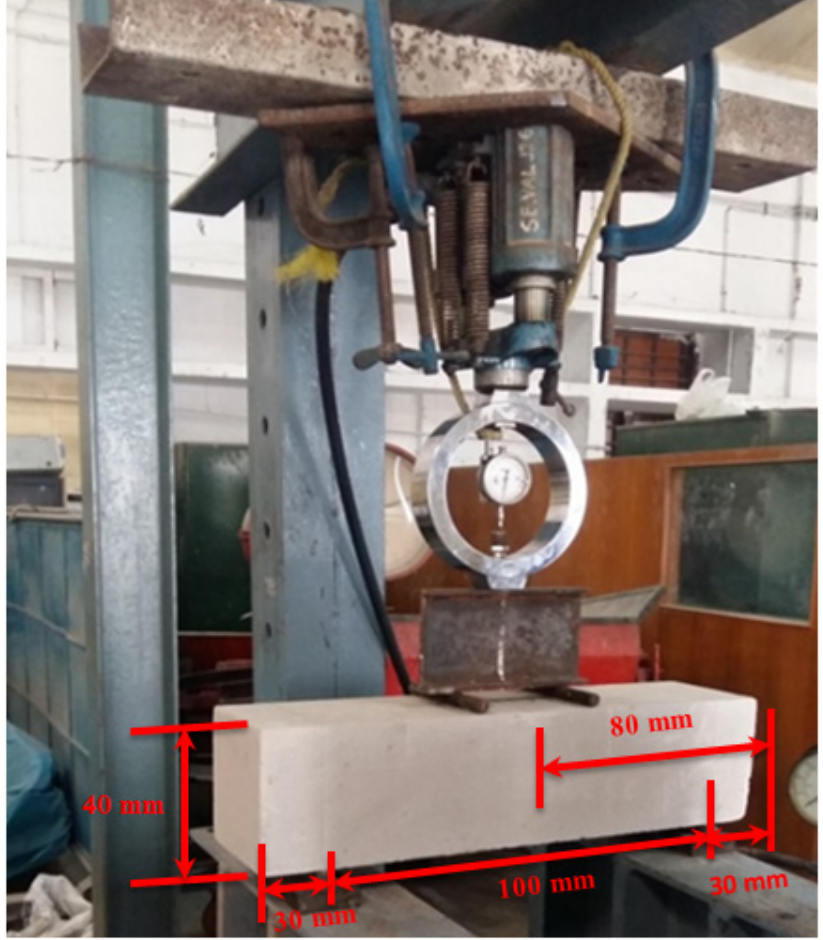
Figure 13. Depiction view of the modulus of rupture experimental test setup.